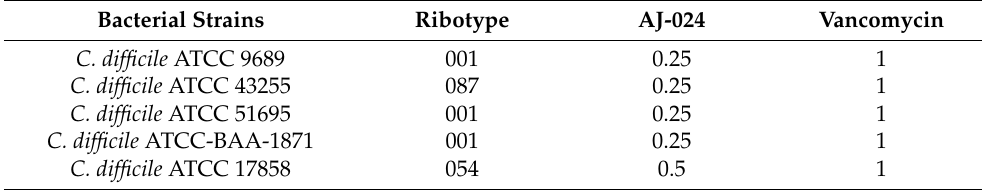
Table 1. In vitro MIC ( µ g/mL) data of AJ-024 against a few representative C. difficile strains.